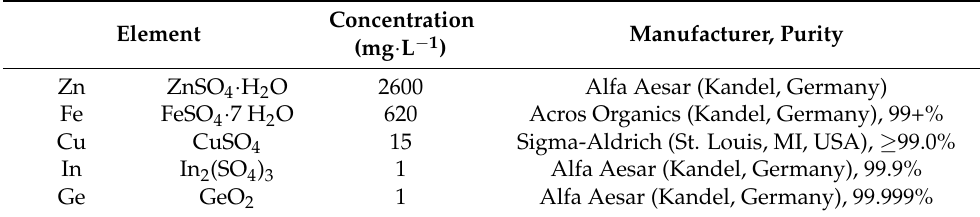
Table 3. Element composition of synthesized PLS.